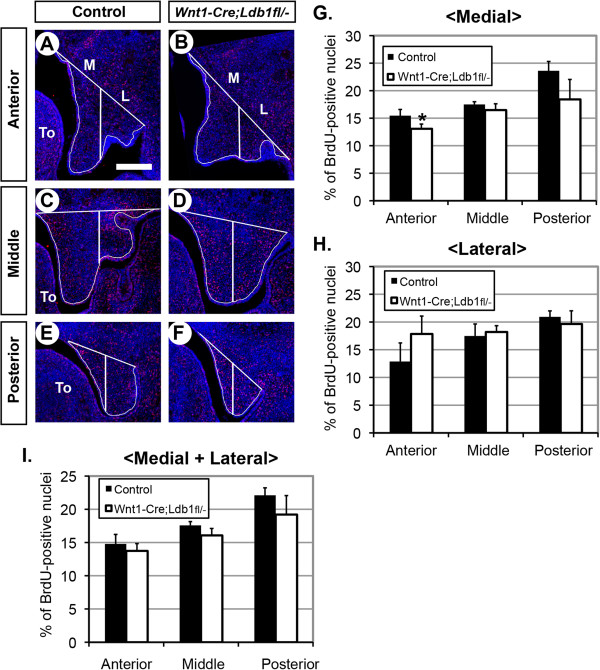
Cell proliferation analysis. (A-F) Coronal sections of the heads from E13.5 embryos were processed with immunofluorescence for BrdU (red) and counter-stained with DAPI for nuclei (blue). (G-H) Quantitative analyses of the mitotic index in the palatal shelf, in the medial (M), lateral (L) or combined (I) areas as demarcated by white lines in A-F. *, p > 0.05. Bar, 0.2 mm.